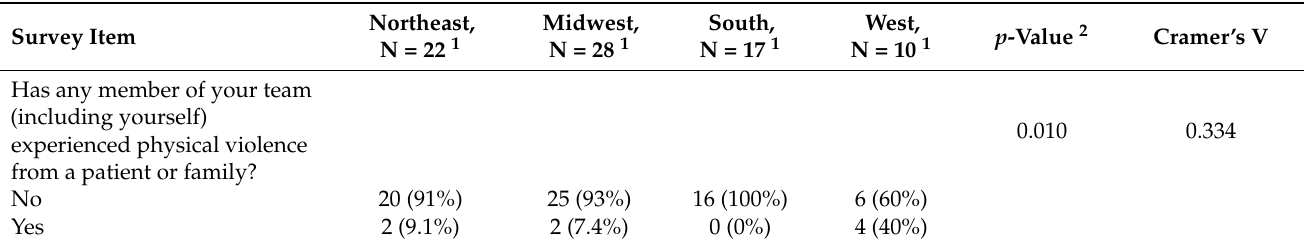
Table 4. Prevalence of Violence among U.S. Providers by Region.